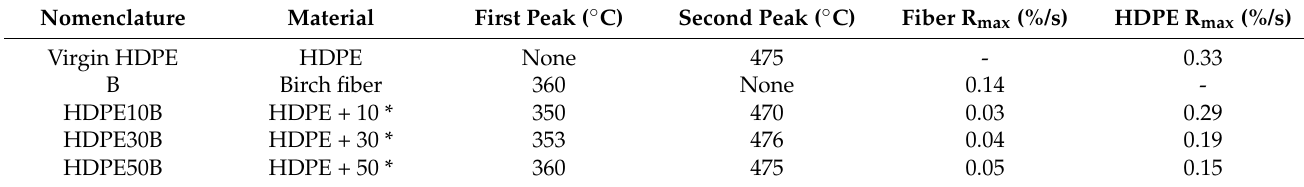
Table 4. Thermal decomposition kinetics of HDPE, birch fiber and composites.